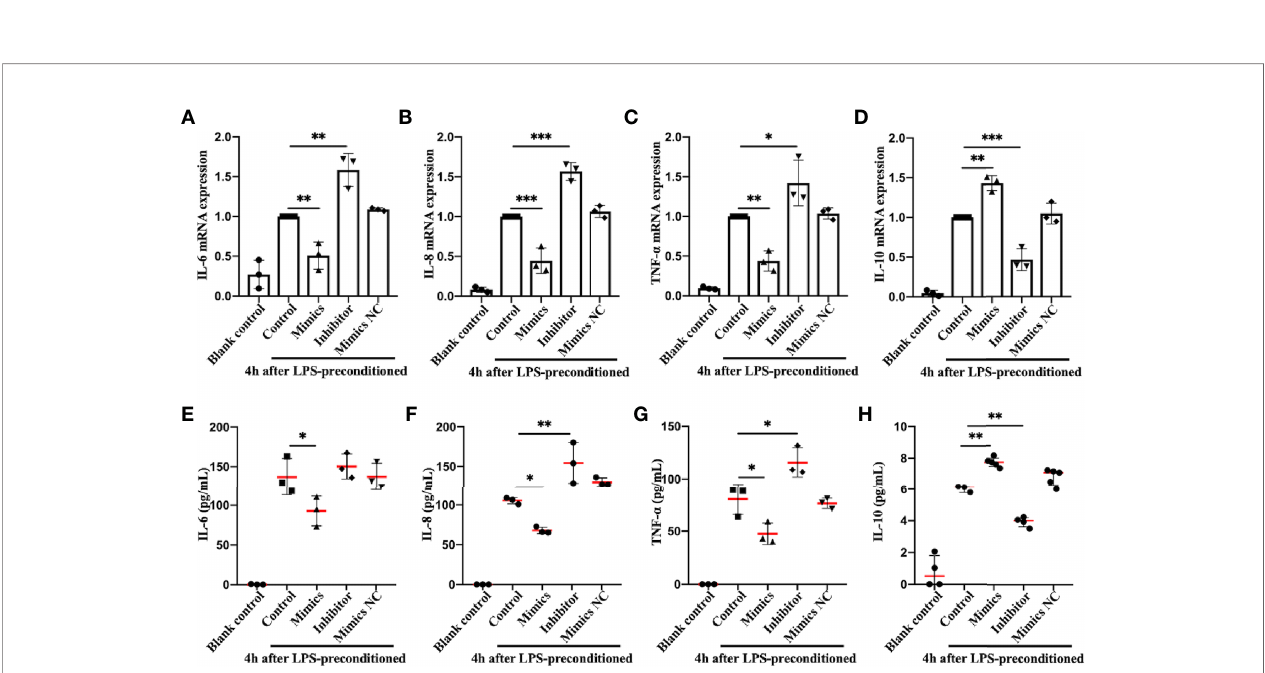
FIGURE 3 | Identi fi cation and expression of in fl ammation-related cytokines in neutrophils in vitro . RT-qPCR (A – D) and ELISA (E – H) detection in the supernatant of IL-6, IL-8, TNF- a , and IL-10 in human freshly isolated neutrophils. Cells were incubated with miR-let-7b mimics, miR-let-7b inhibitor, and miR-let-7b mimics NC (100 nM, respectively), and the supernatant was collected at 10 hours after stimulation with 100 ng/mL LPS for 4 h. Data represent mean ± SD (n=3 – 5). Tukey ’ s multiple comparison tests were used to generate the P-values indicated in the fi gure. *P < 0.05, **P < 0.01, ***P <